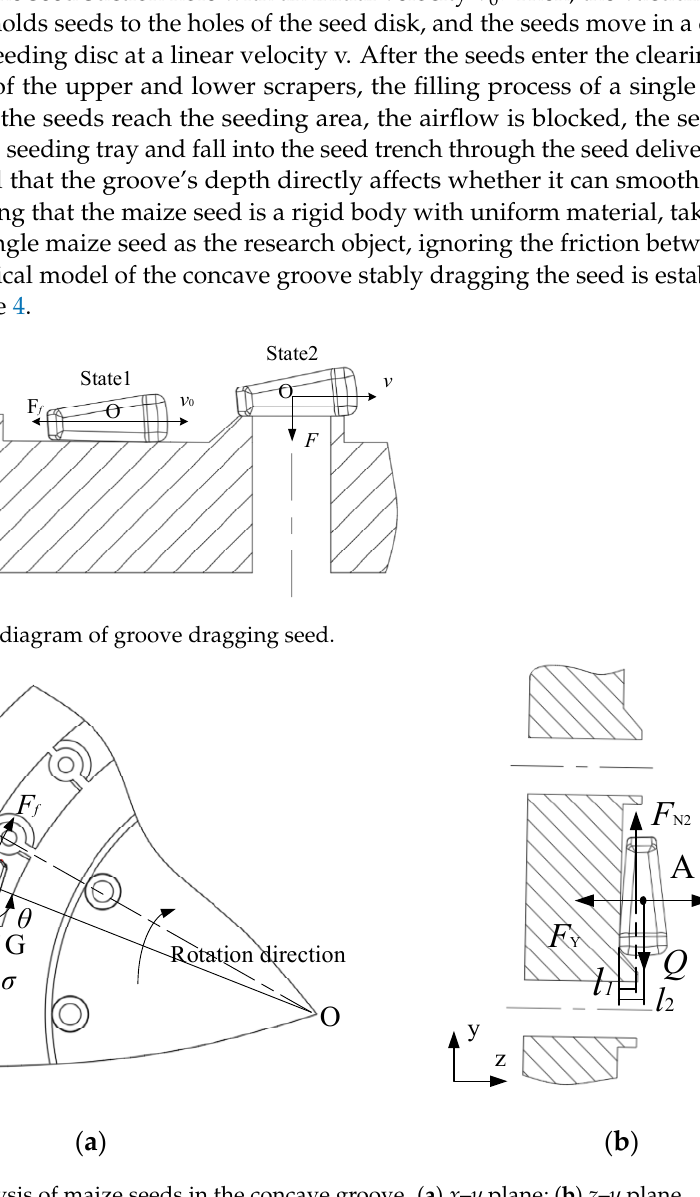
Seed disk hole Figure 2. Two-dimensional sketch of the seed disk.